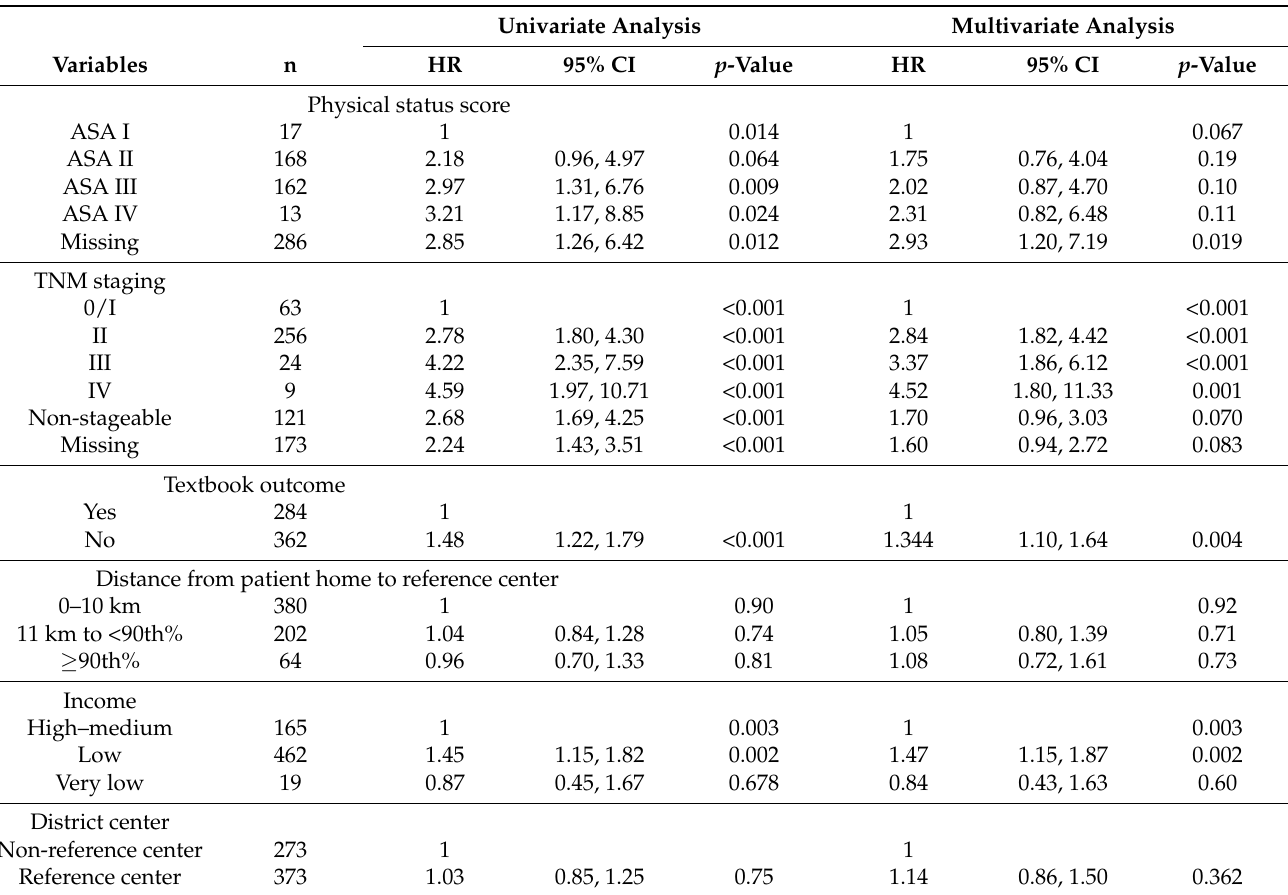
Table 3. Cont. Univariate Analysis Multivariate Analysis